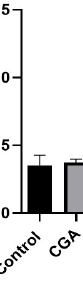
Figure 4. LPO marker (MDA) in cardiac tissue. CGA significantly reversed the DOX-related LPO via the reduction of MDA levels. Data are presented as the means ± SD. **** p < 0.0001 vs. the control group, #### p < 0.0001 vs. the DOX group (n = 7). CGA: Chlorogenic acid (100 mg/kg); DOX: Doxorubicin (15 mg/kg); MDA: Malondialdehyde.